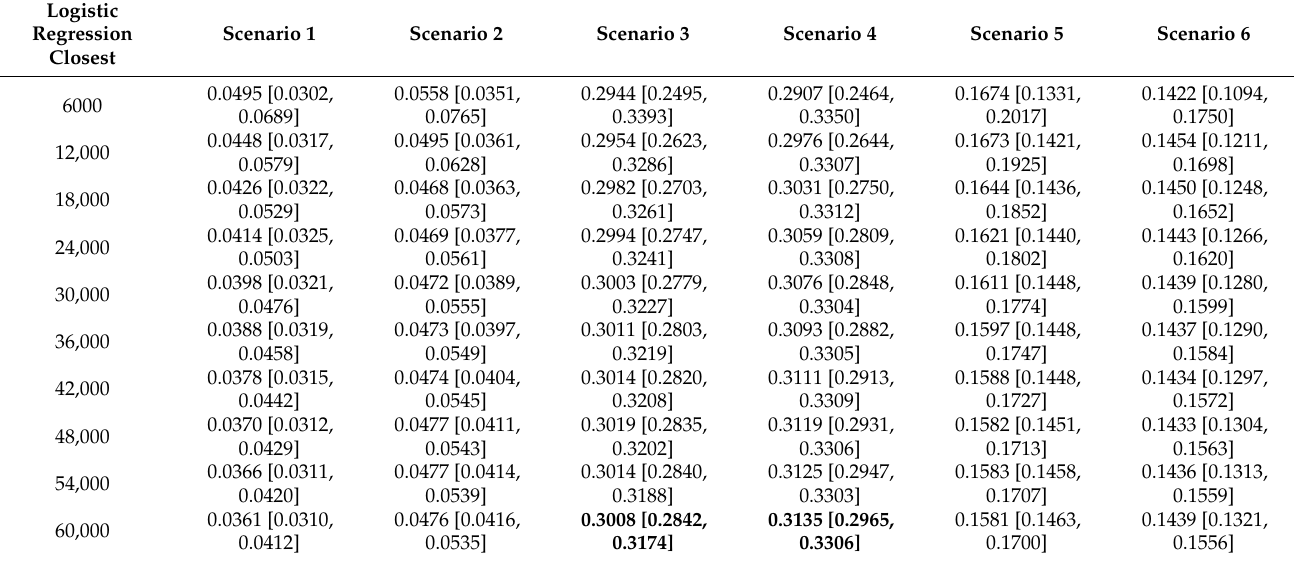
Table 3. The most likely demographic scenario for B. dorsalis by the DIYABC analysis ‘A’ (see Supplementary Materials Figures S1 and S7). Scenario 1: Subgroup 1 (CN + VN) as an ancestor group, Subgroup 2 (TW + TH) first separated from Subgroup 1 (CN + VN), then Subgroup 3 (PH + MY + IN) diverged from Subgroup 2 (TW + TH) (Supplementary Materials Figure S2a). Scenario 2: ancestor group of Subgroup 1 (CH + VN), similar to Scenario 1, but reversed the diverging order of Subgroup 2 (TW + TH) and Subgroup 3 (PH + MY + IN) (Supplementary Materials Figure S2b). Scenarios 3 and 4: Subgroup 2 (TW + TH) as the ancestor group, and the diverging order of Subgroup 1 (CH + VN) and Subgroup 3 (PH + MY + IN) (Supplementary Materials Figure S2c,d). Scenarios 5 and 6: Subgroup 3 (PH + MY + IN) as the ancestor group, and the diverging order of Subgroup 1 (CH + VN) and Subgroup 2 (TW + TH) (Supplementary Materials Figure S2e,f). Values in bold indicate the first and second best scenarios in the analysis